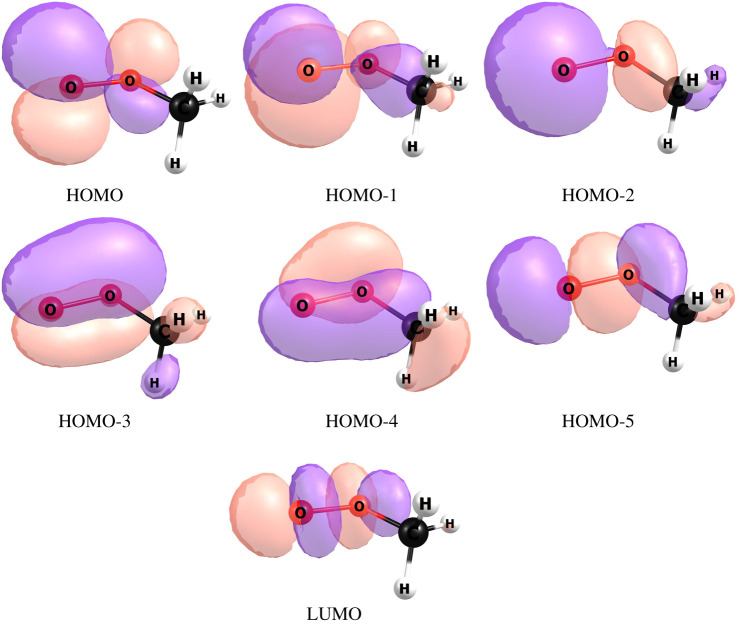
The MOs of the active space used for CH3O2.